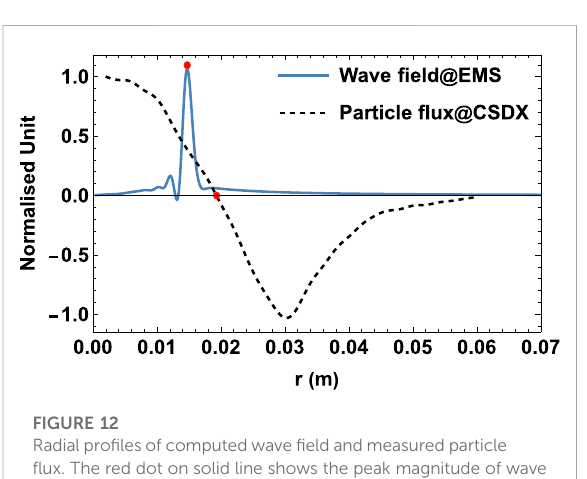
FIGURE 12 Radial pro fi les of computed wave fi eld and measured particle fl ux. The red dot on solid line shows the peak magnitude of wave fi eld at r = 0.015 m, and the red dot on dashed line denotes the sign-inverse point of particle fl ux at r ≈ 0.02 m.